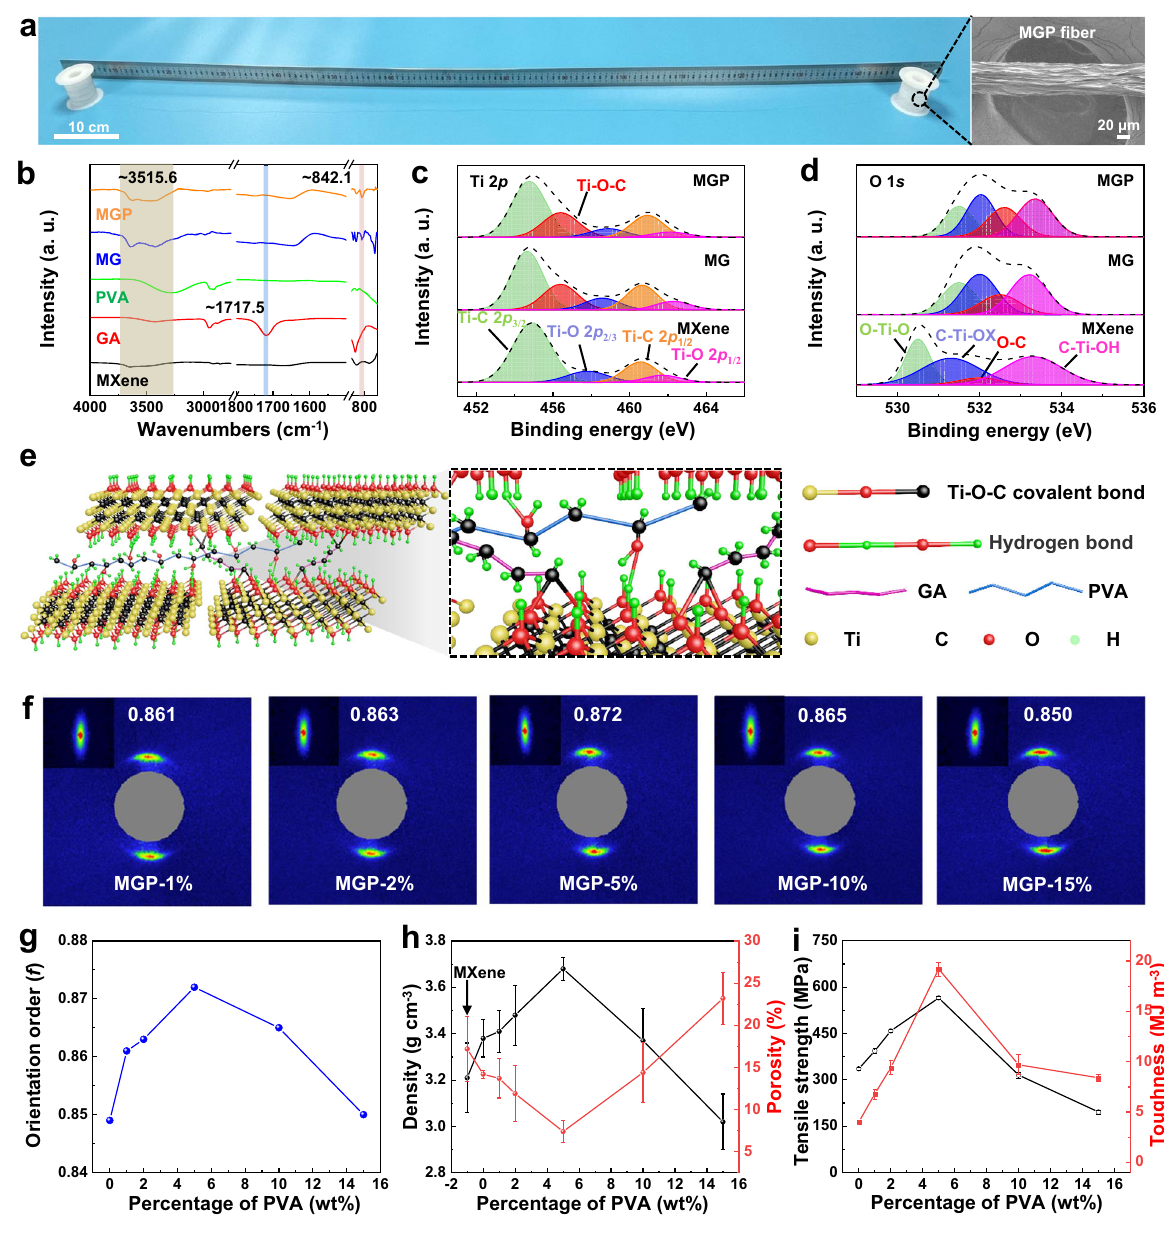
Fig. 2 | Interfacial interactions and mechanical characterization of MXene fi bers via wet-spinning. a Photograph of several meter-long MGP fi bers with the axialSEMmorphology. b FTIRspectraoftheobtained fi bers. c Ti2 p spectraand d O 1 s spectra of pure MXene, MG, and MGP fi bers. e Structure graph of the covalent bond between MXene nanosheets and GA, and hydrogen bond between MXene nanosheets and PVA. f WAXS and SAXS (inset) patterns graphs of MGP fi bers with